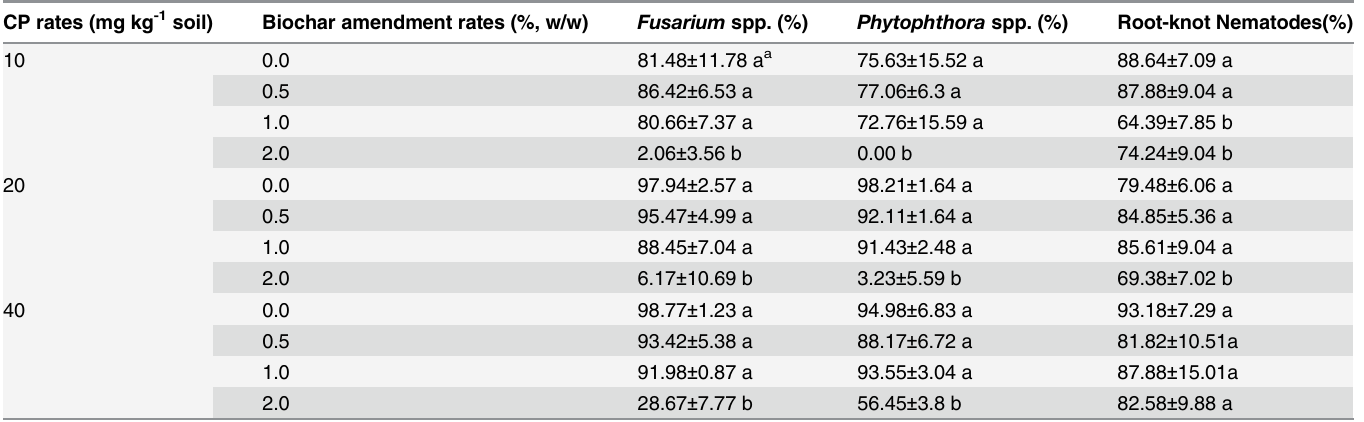
Table 4. Efficacy of CP fumigation treatments on Fusarium spp., Phytophthora spp. and Root-knot nematodes in biochar amended soil. CP rates (mg kg -1 soil) Biochar amendment rates (%,